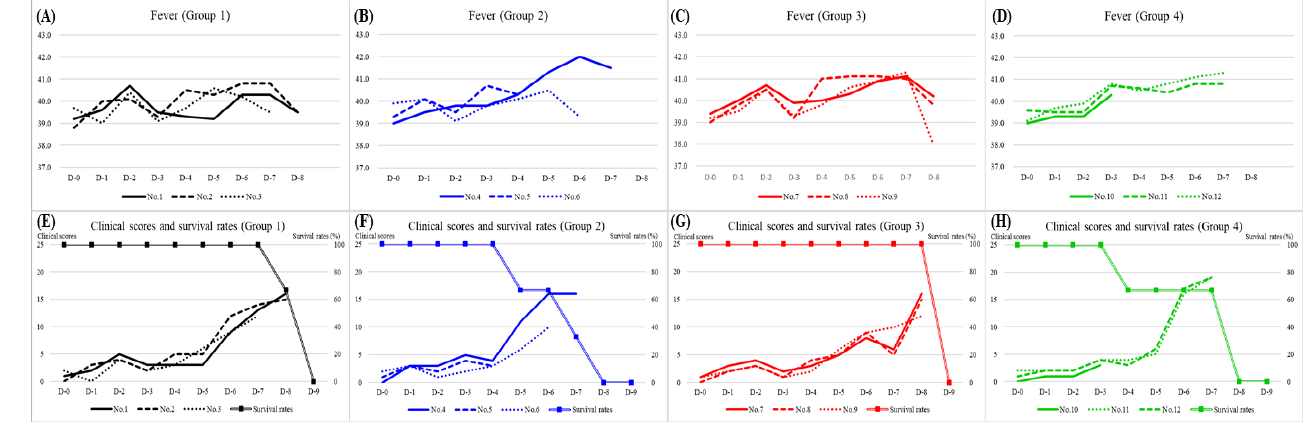
Figure 1. Results of rectal temperature, clinical score, and survival rate in four groups. Change of rectal temperature ( A – D ) and clinical scores and survival rates ( E – H ) of four groups.